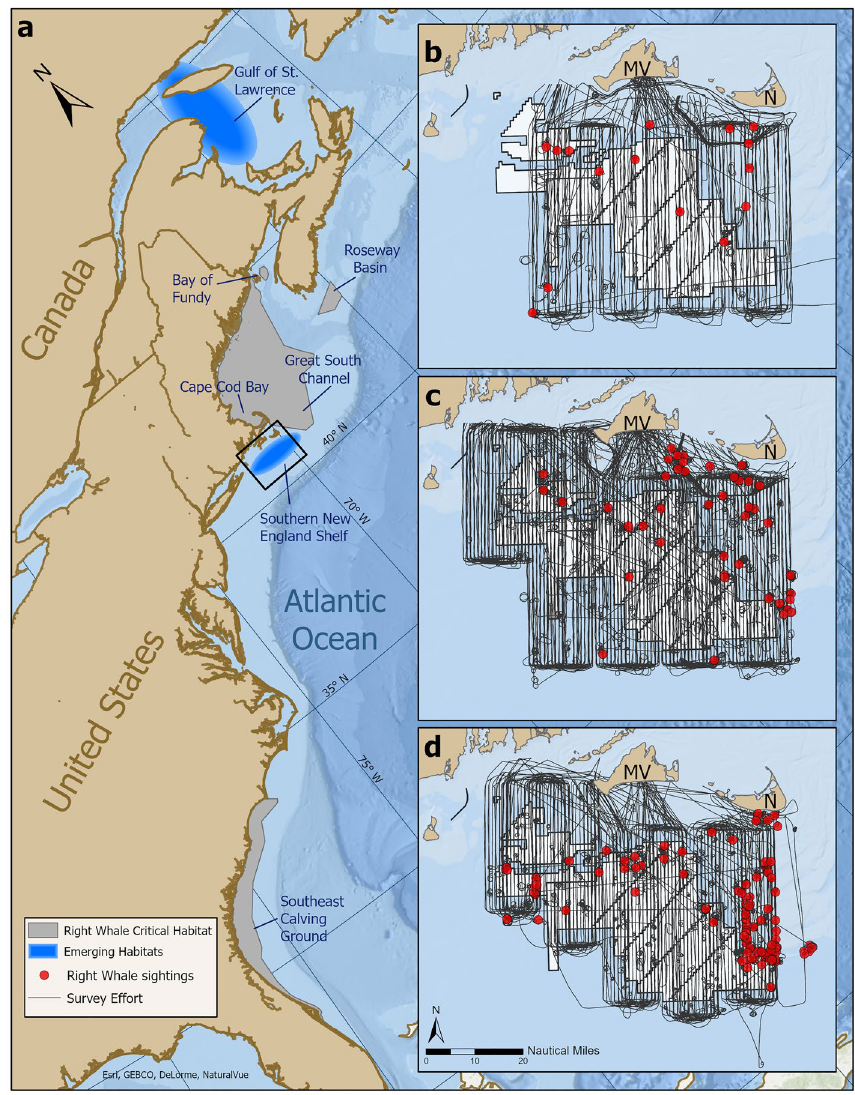
Figure 1. Known right whale habitats in the Northwest Atlantic. ( a ) Gray polygons encompass known right whale habitats; blue ovals represent emerging habitats. Black box and insets show the New England Aquarium broad-scale survey area. ( b – d ) Broad-scale survey effort (black lines) and right whale sightings (red circles) during three different time periods: ( b ) 2011–2012, ( c ) 2013–2015, ( d ) 2017–2019. White shading represents MA/RI wind energy lease areas. MV = Martha’s Vineyard, N = Nantucket. Figure was created using ArcGIS Pro (version